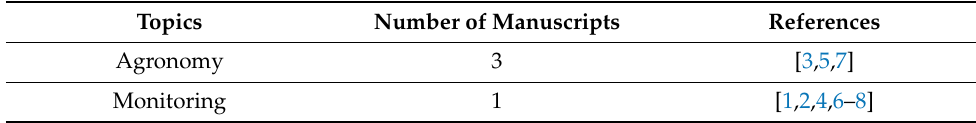
Table 3. Topics for low-cost inventions and